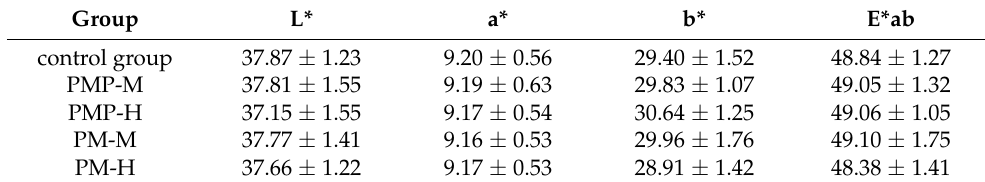
Table 3. Fecal chroma value after drug withdrawal (x ± s).